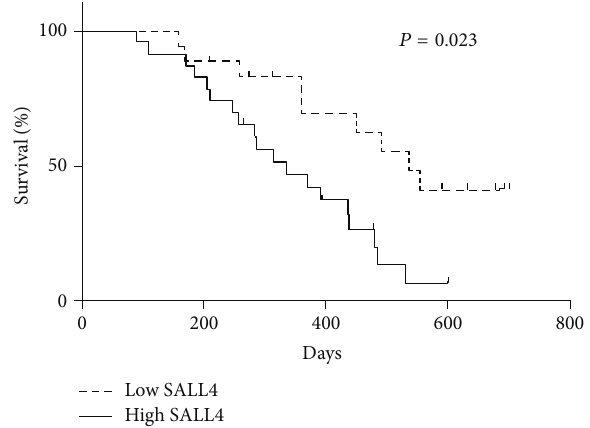
Figure 3: Kaplan-Meier curves showed a lower rate of overall survival in HCC patients with high expression of serum SALL4 than with low expression of serum